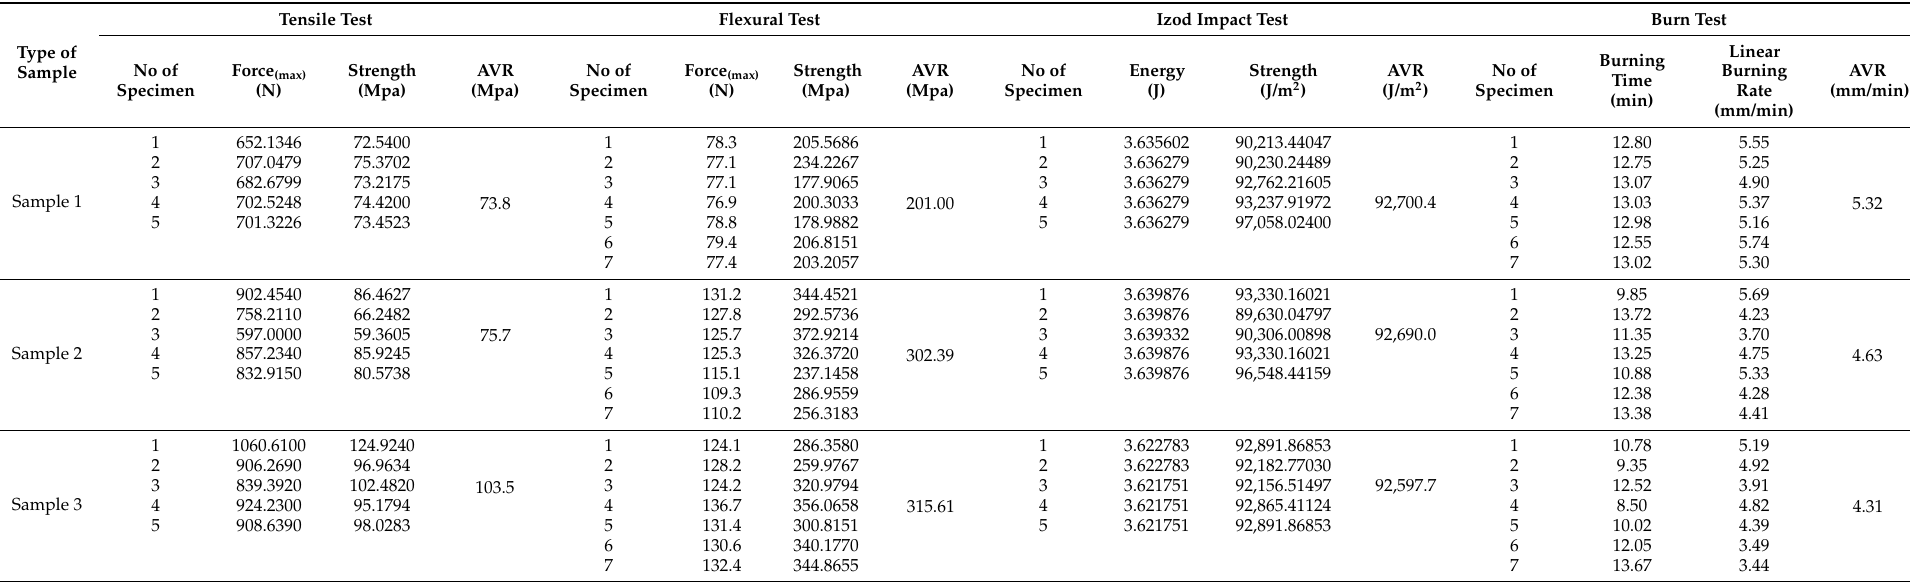
Table 2. Data sample test